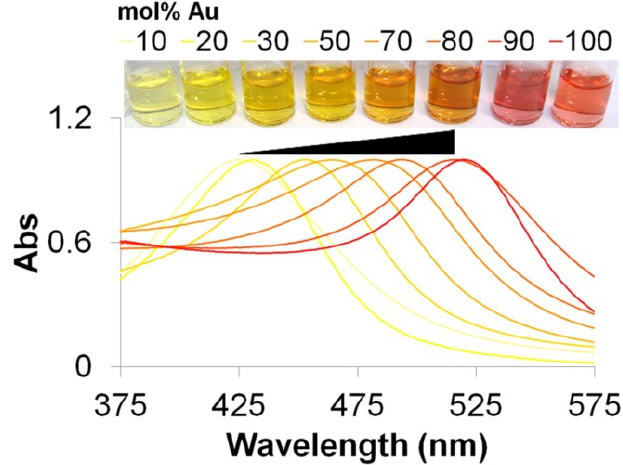
Figure 1. Example of LSPR modulation through different NP compositions. The LSPR absorption band of gold/silver alloy NPs increases to longer wavelengths with increasing amounts of